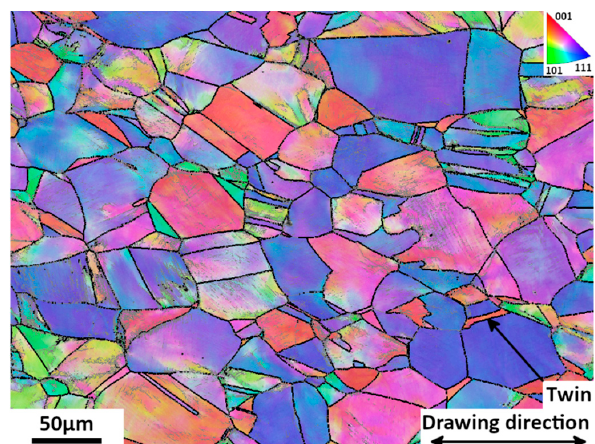
Figure 2. EBSD drawing direction Inverse Pole Figure (IPF) map of austenite with high angle boundaries (10°) outlined in black of the as-received 25% cold-drawn sample. Step size is 300 nm.